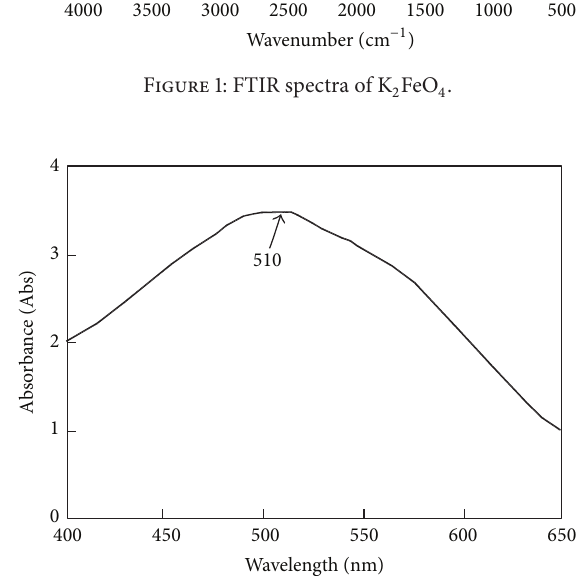
Figure 2: UV-Vis DRS of K 2 FeO 4